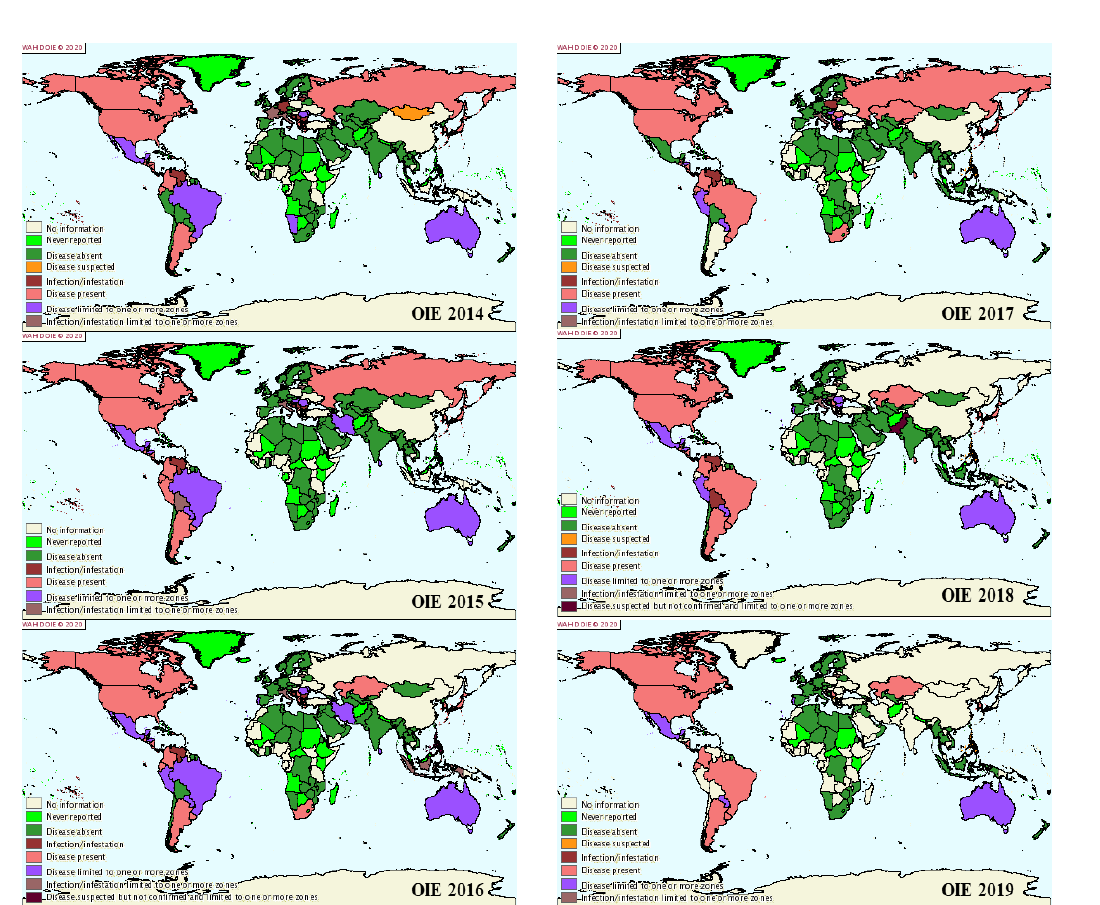
Figure 2. EBL world distribution map based on the last 5 years (2014–2019) [16].